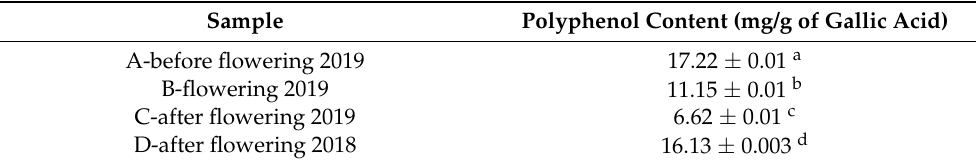
Table 1. The total content of polyphenolic compounds in hemp concentrates.